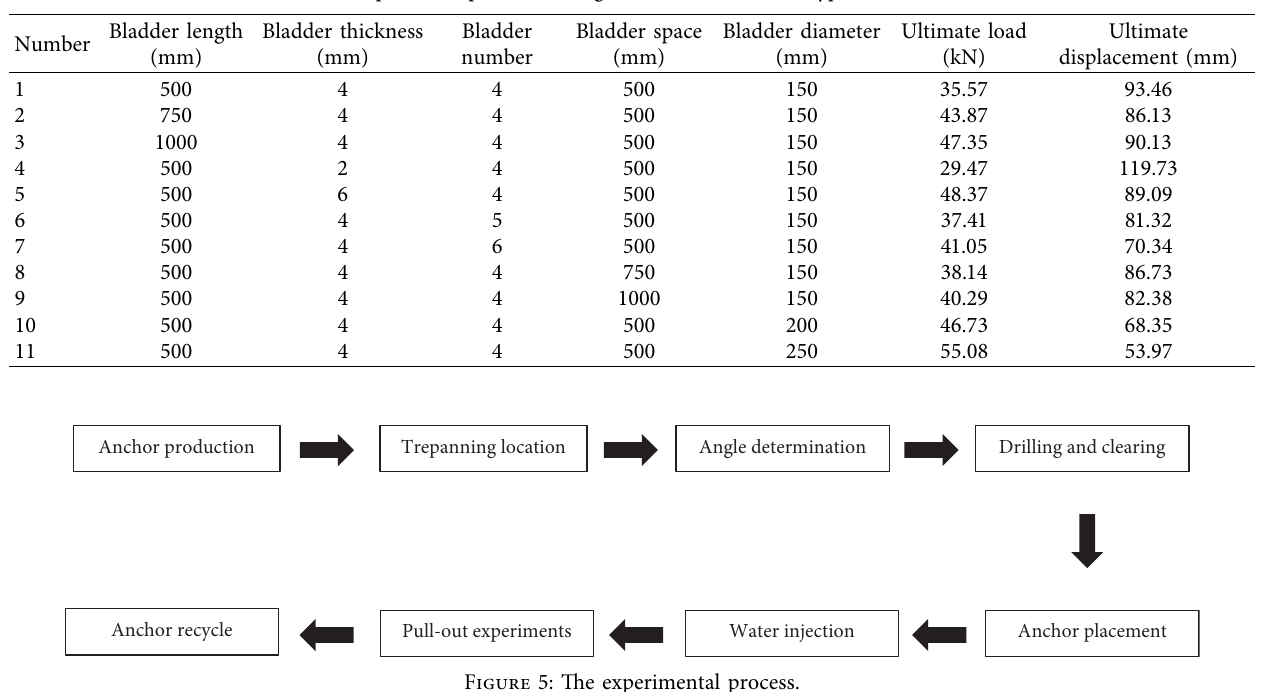
Table 2: The pullout experiment design of the multibladder-type inflatable anchor.